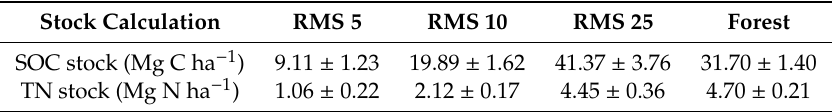
Table 6. Estimation of SOC and TN stock in reclaimed chronosequence and forest